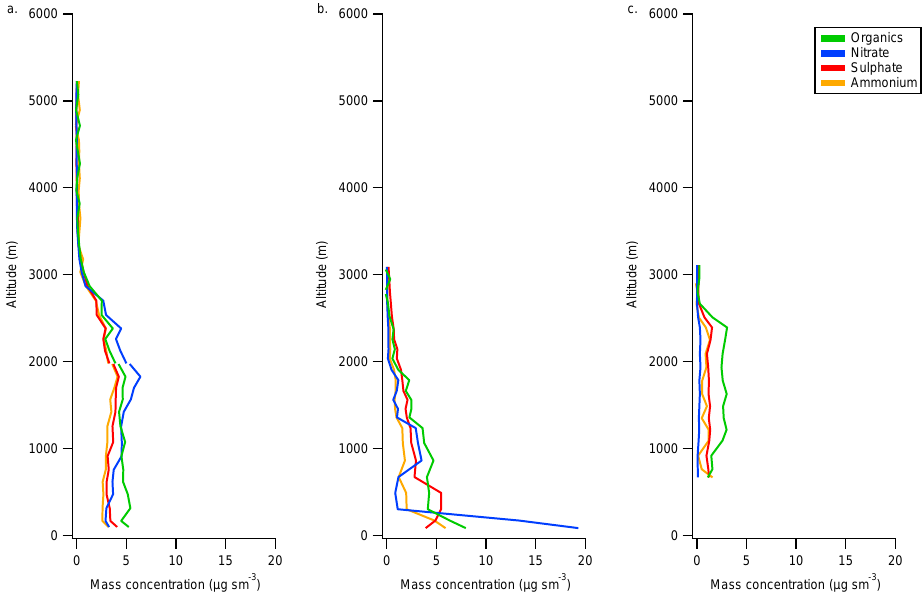
Fig. 3. Vertical profiles of aerosol chemcial composition from (a) B374 in the Eastern Atlantic (zone 1), (b) B362 in the North Sea off the UK east coast and (c) B369 over Latvia in North-Eastern Europe. The profile locations are marked on Fig. 1a.